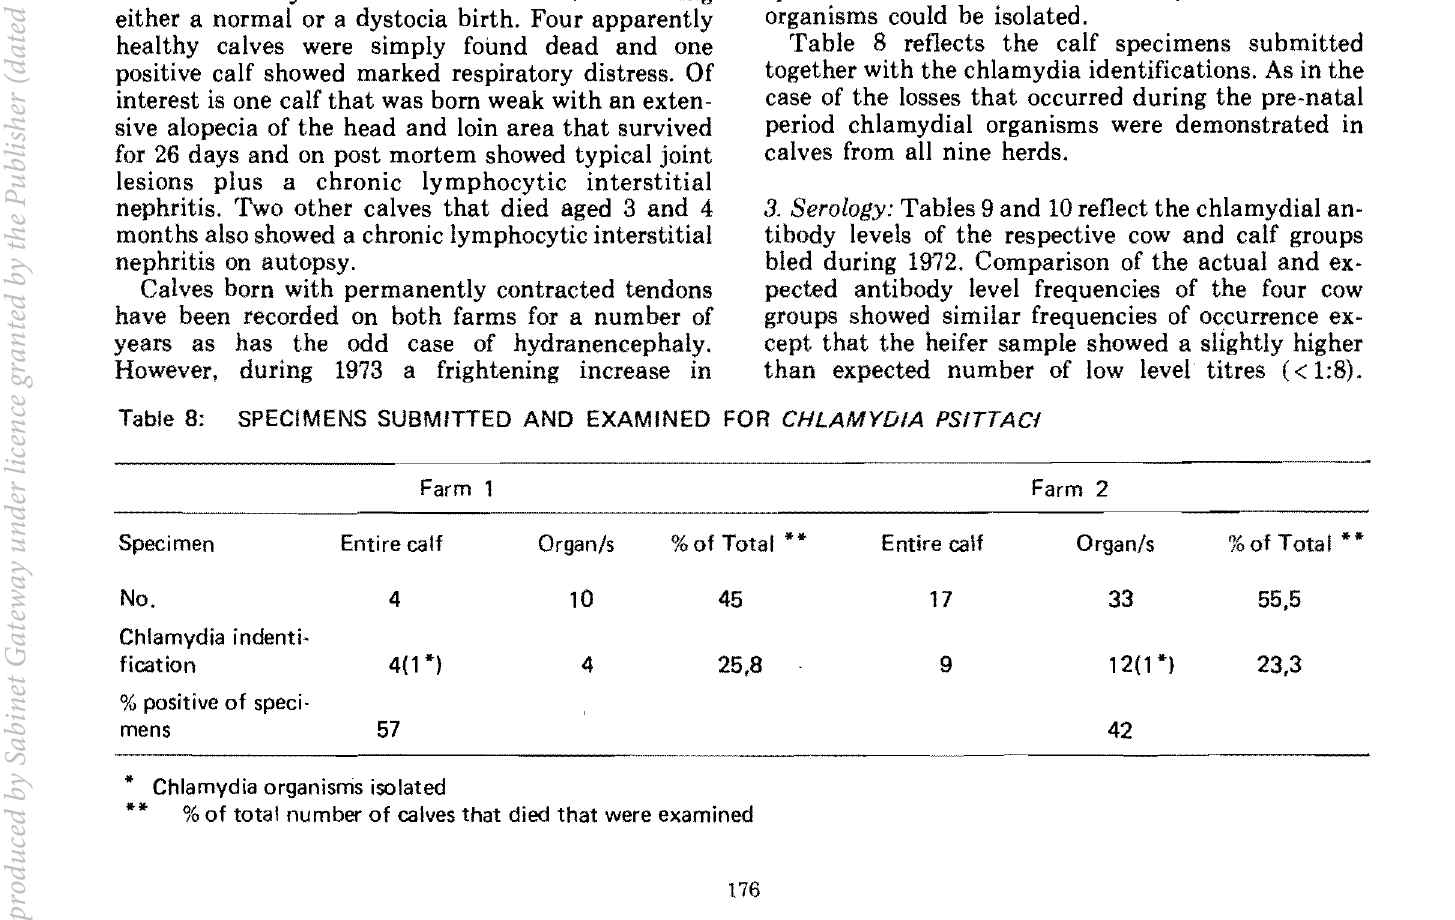
SPECIMENS SUBMITTED AND EXAMINED FOR CHLAMYDIA